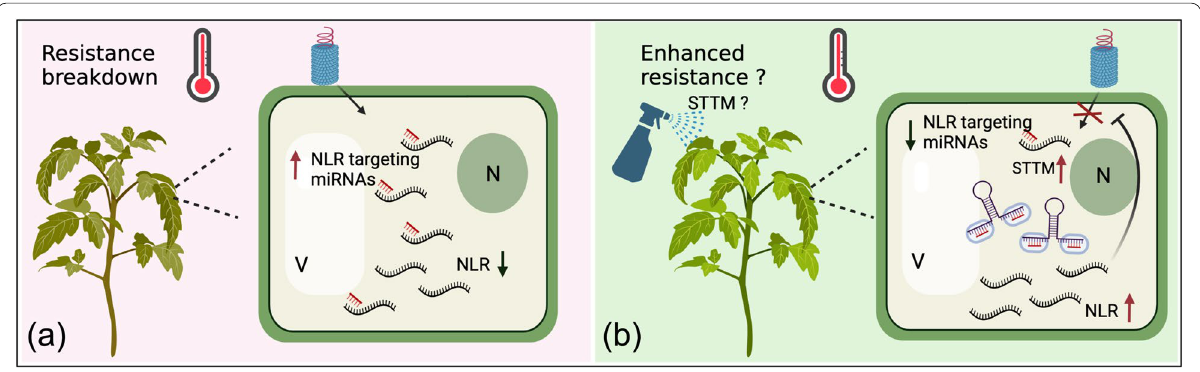
Fig. 3 Schematic representation of exogenous application of short tandem target mimic (STTM) RNA molecules to degrade or sequester nucleotide‑binding leucine‑rich repeat (NLR) ‑ targeting miRNAs. a At elevated temperatures, plant resistance to viruses may be suppressed by miRNA‑mediated downregulation of NLRs. b STTM RNA molecules that target NLR‑targeting miRNAs are delivered into the cytoplasm to reduce the abundance of miRNAs, which hence upregulates the expression of NLRs and enhances plant resistance. V